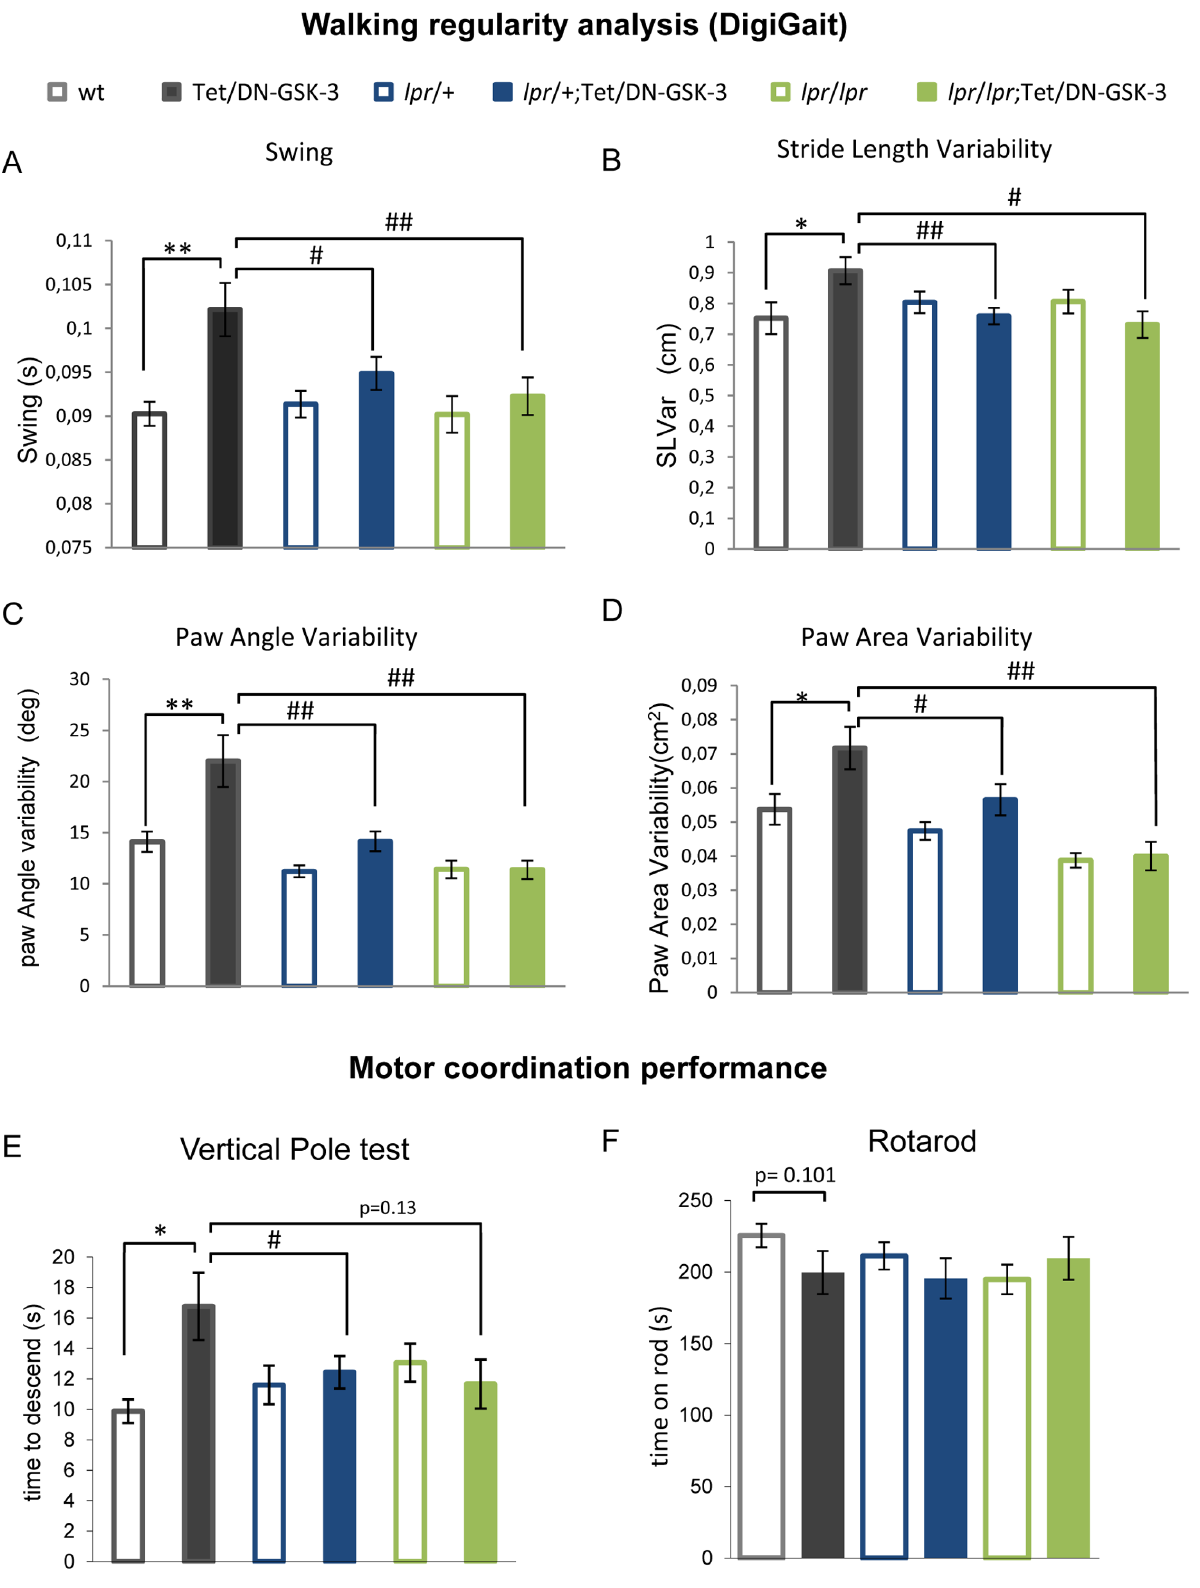
Figure 3. Motor deficits in Tet/DN-GSK-3 mice are Fas dependent. A–D. Analysis of gait parameters by using the DigiGait apparatus. Analysis of swing duration (A), stride length variability (B), paw angle variability (C) and paw area variability (D) of experimental mice (wt, n=13; Tet/DN-GSK-3, n=12; lpr / + , n=21; lpr / + ;Tet/DN-GSK-3, n=21; lpr/lpr , n=14 and lpr / lpr ;Tet/DN-GSK-3, n=8). Statistical analysis of swing duration, stride length